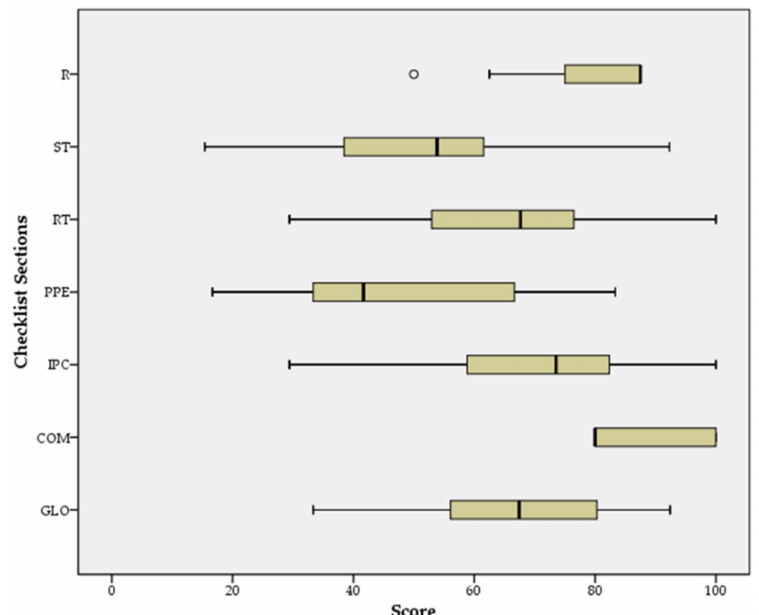
Figure 2. Distribution of facility scores by checklist section (R: restrictions policies for visitors and non-essential staff; ST: staff training, monitoring, and screening; RT: resident training, monitoring, and screening; PPE: Availability of PPE and other supplies; IPC: infection prevention and control (IPC) practices; COM: communication; GLO: global checklist score).